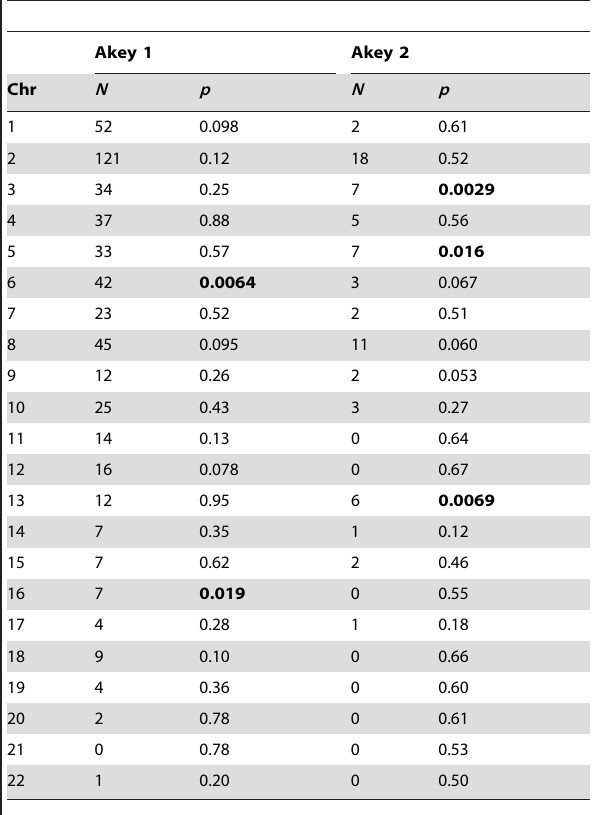
Table 2. The number of patches that appear in the Akey’s [36] catalogue of putative targets of selection.